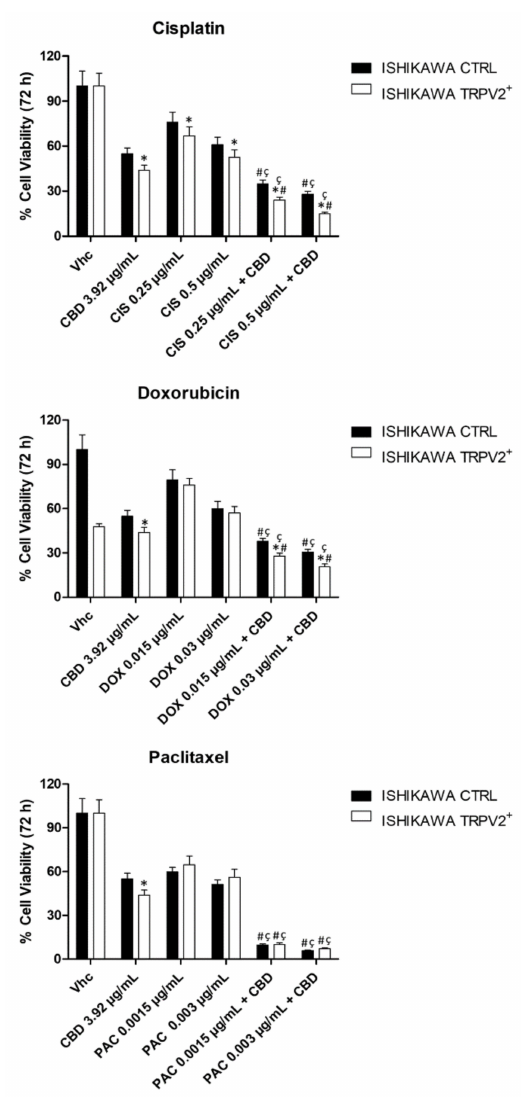
Figure 14. CBD improved chemotherapeutic drug e ff ects in TRPV2-transfected Ishikawa cell line. Cell viability was determined in EC cell lines by MTT assay. Cells were treated for 72 h with CBD, alone and in combination with di ff erent doses of CIS, DOX and PAC. Data shown are expressed as mean ± SD of three separate experiments. * p < 0.05 TRPV2 + vs. control, # p < 0.05 vs. CBD alone, ç p < 0.05 vs. chemotherapeutic drug